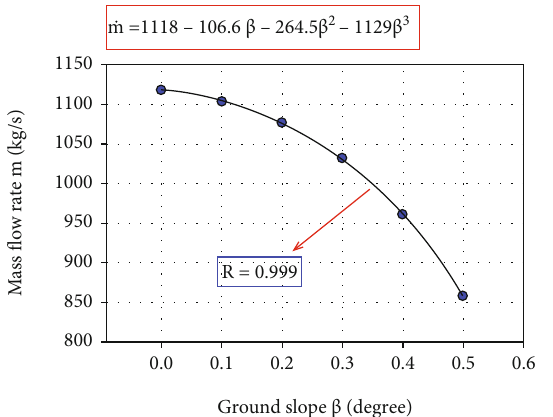
Figure 7: Mass fl ow rates in the pilot plant for di ff erent ground slope angles.